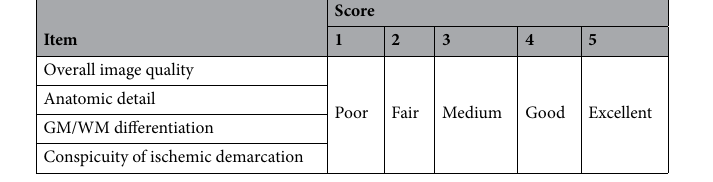
Table 2. Scoring scheme for qualitative image analysis.